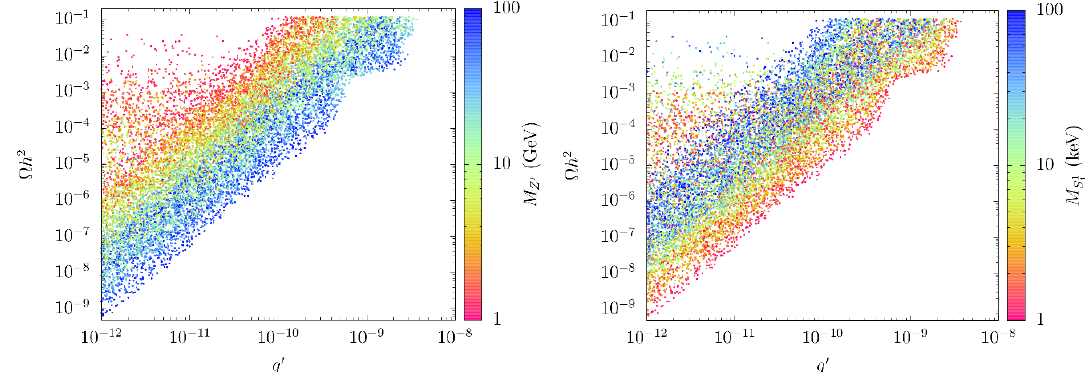
Figure 7 . Allowed points in ( g 0 ; (cid:10) h 2 ) plane after imposing a constraint (cid:10) h 2 (cid:20) 0 : 12, as an upper bound on the WDM relic density (cid:10) h 2 . The color bars of left and right panels correspond to the Z 0 mass ( M Z 0 ) in GeV and WDM mass ( M ) in keV, respectively. S 1 1